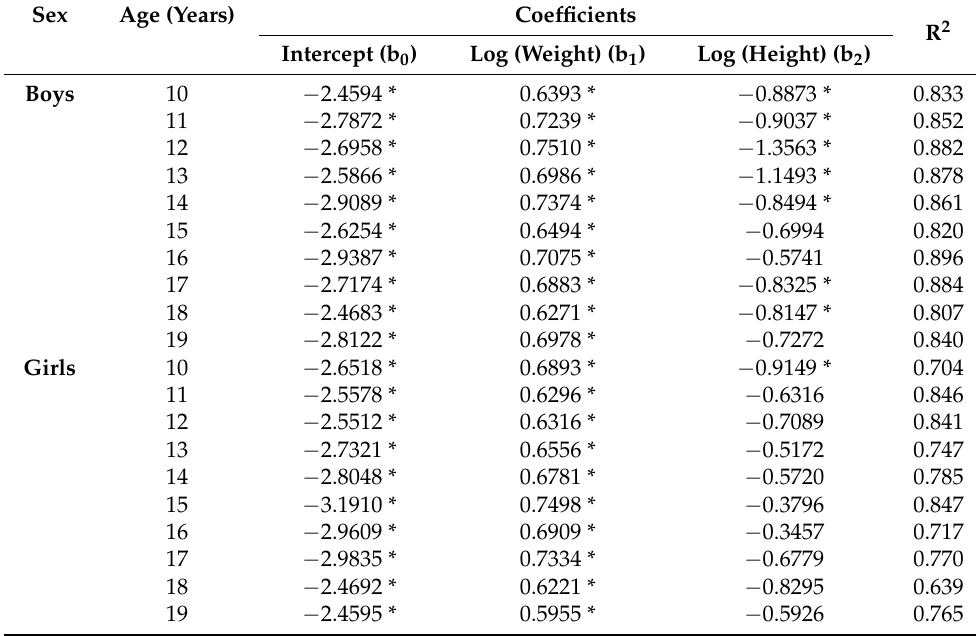
Table 3. Regression coefficients of the relationships among log of waist circumference (m), log of weight (kg), and log of height (m) according to